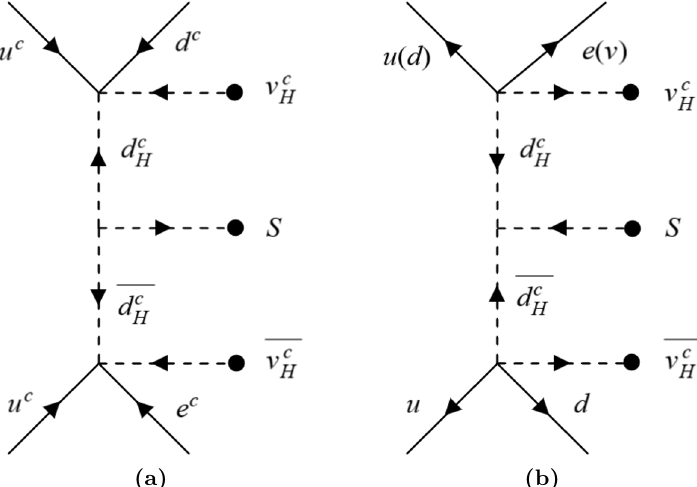
Figure 2. Dimension-six proton decay diagrams with chirality (cid:13)ipping mediation. Dashed lines represent bosons, solid lines represent fermions, and dots represent the vevs. These are graphs between the B -violating superpotential coupling F c F c H c H c ( FFH c H c ) and the B -conserving superpotential coupling F c F c H c H c ( FFH c H c